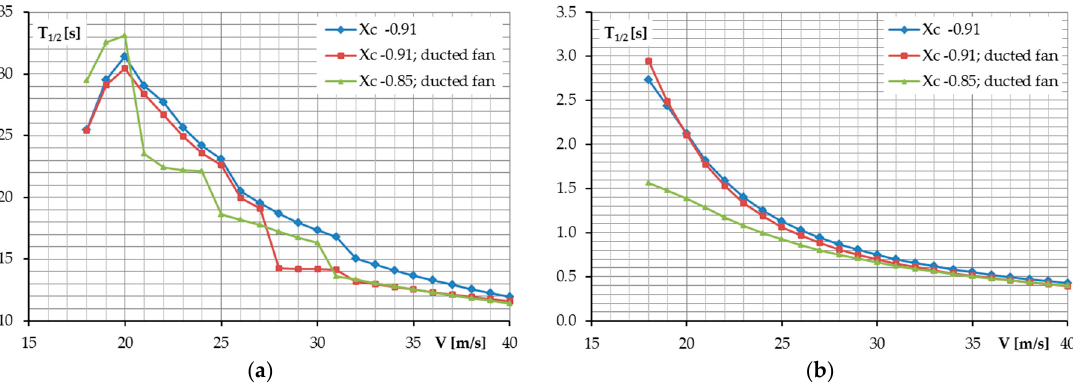
Figure 25. Dynamic stability characteristics of the airplane with ducted fan propulsion. Time to halve the amplitude of oscillations: ( a ) phugoid motion; and ( b ) Dutch roll motion.